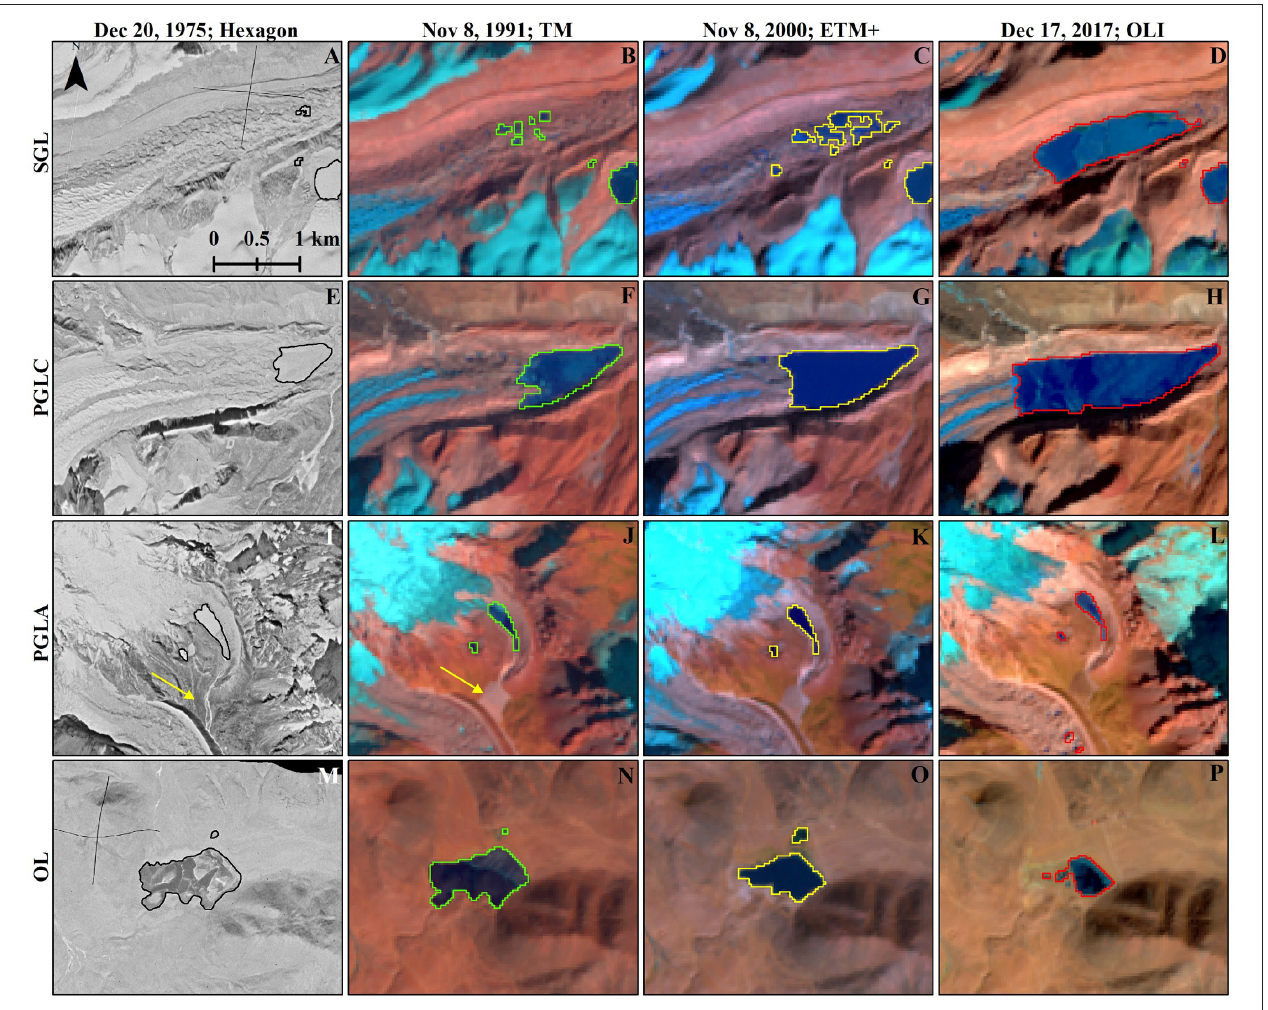
FIGURE 7 | Change in supraglacial lakes (SGL; A–D ), pro/peri glacial lakes in contact with glacier (PGLC; E–H ), pro/peri glacial lakes away from glacier (PGLA; I–L ) and other lakes (OL; M–P ) between 1975 and 2017. The yellow arrow shown in panels (I,J) shows the traces of possible lake breach sometimes between 1975 and 1991. For location of lakes please refer Figure 1